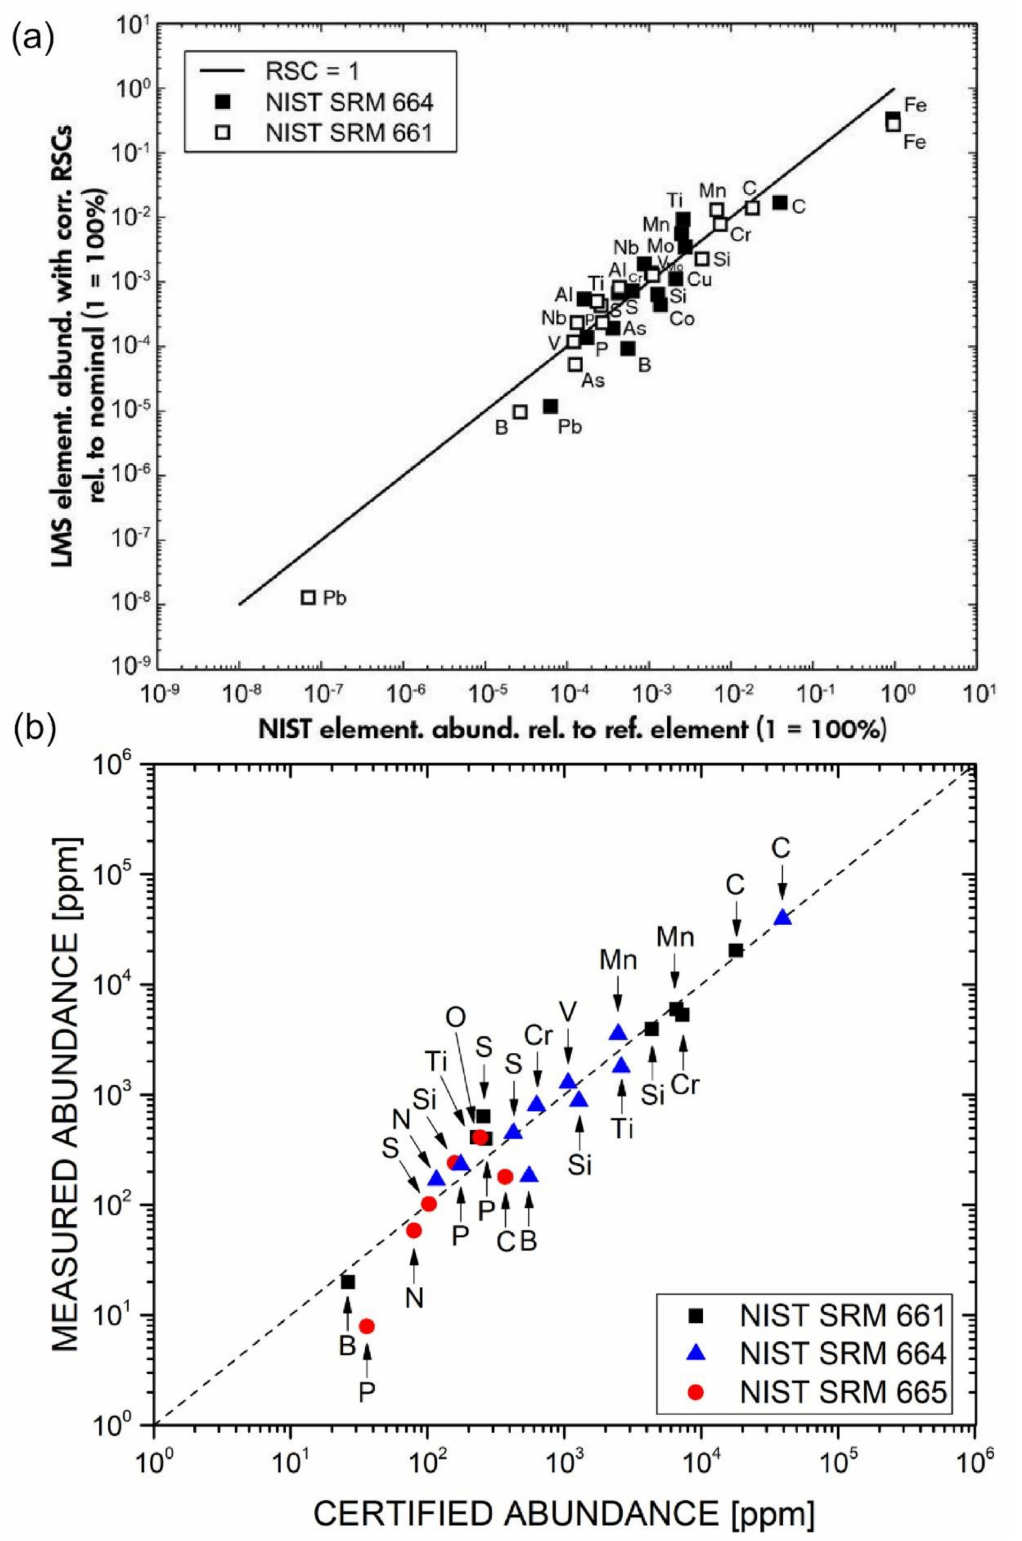
Figure 8. ( a ) Comparison of the measured and certified atomic abundances by SP IR fs-LMS; ( b ) Comparison of the measured and certified atomic abundances by DP IR fs-LMS. The Fe measurements are low due to the 56 Fe signal saturation effects in the detector channel. Reprinted with permission from